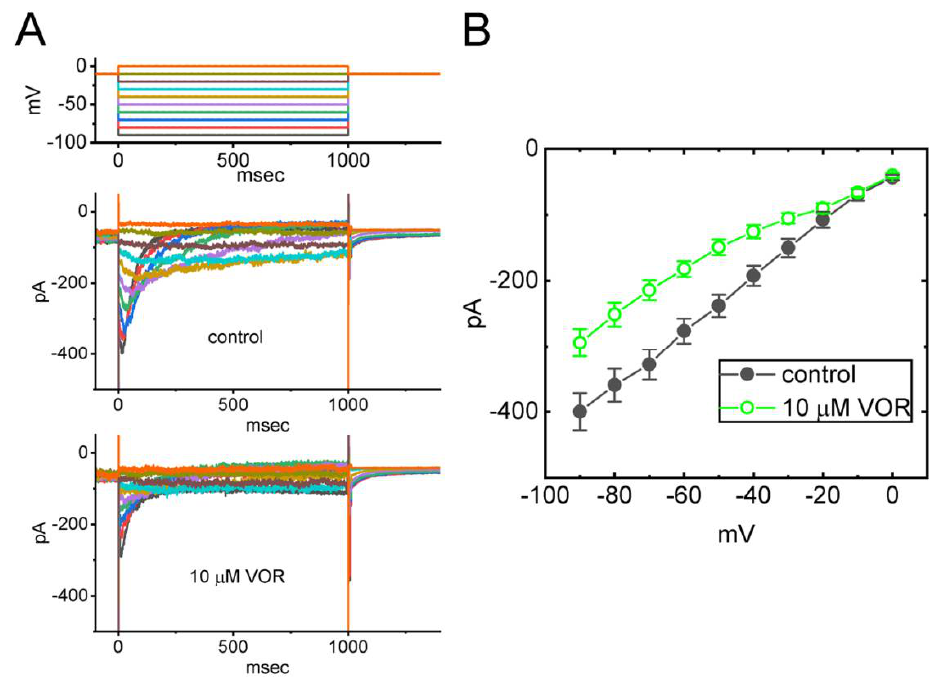
Figure 9. Effect of VOR on erg -mediated K + current ( I K(erg) ) identified in GH 3 cells. This stage of experiments was undertaken in cells bathed in high-K + , Ca 2+ -free solution, and the electrode was filled with K + -containing solution. The examined cell was voltage-clamped at − 10 mV, and a series of voltage pulses between − 90 and 0 mV was applied to it. ( A ) Representative current traces obtained in the control period (upper, i.e., absence of VOR) and during exposure to 10 µ M VOR (lower). The uppermost part is the voltage protocol used. ( B ) Mean I-V relationship of deactivating I K(erg) in the absence (filled black symbols) and presence (open green symbols) of 10 µ M VOR (mean ± SEM; n = 8 for each point). The peak I K(erg) amplitudes with or without the VOR addition were measured at the start of each voltage step.